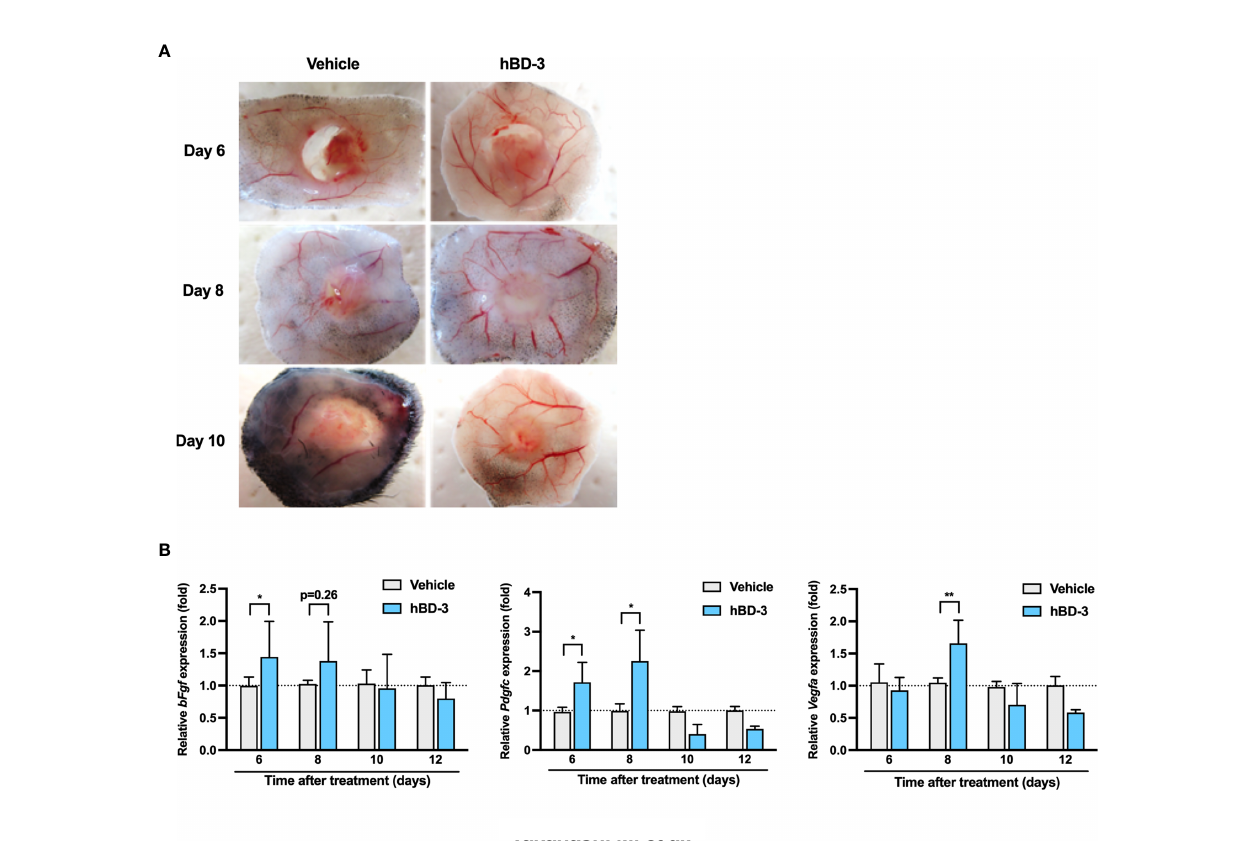
FIGURE 2 | hBD-3 promotes angiogenesis and induces the production of angiogenic growth factors. (A) Representative images of the macroscopic appearance of newly formed blood vessels at the wound sites on days 6, 8 and 10 post-injury in the mice treated with 0.01% acetic acid (vehicle) and 200 µg/ml hBD-3. (B) Biopsies were obtained from the dorsal skin wound tissues, and the mRNA expression of bFgf, Pdgf , and Vegfa was evaluated by quantitative real-time PCR analysis using SYBR Premix Ex Taq. The P value was calculated using one-way ANOVA with Tukey ’ s multiple comparisons test. * P < 0.05 and ** P < 0.01 for comparisons between the vehicle-treated and hBD-3-treated wounds. n =